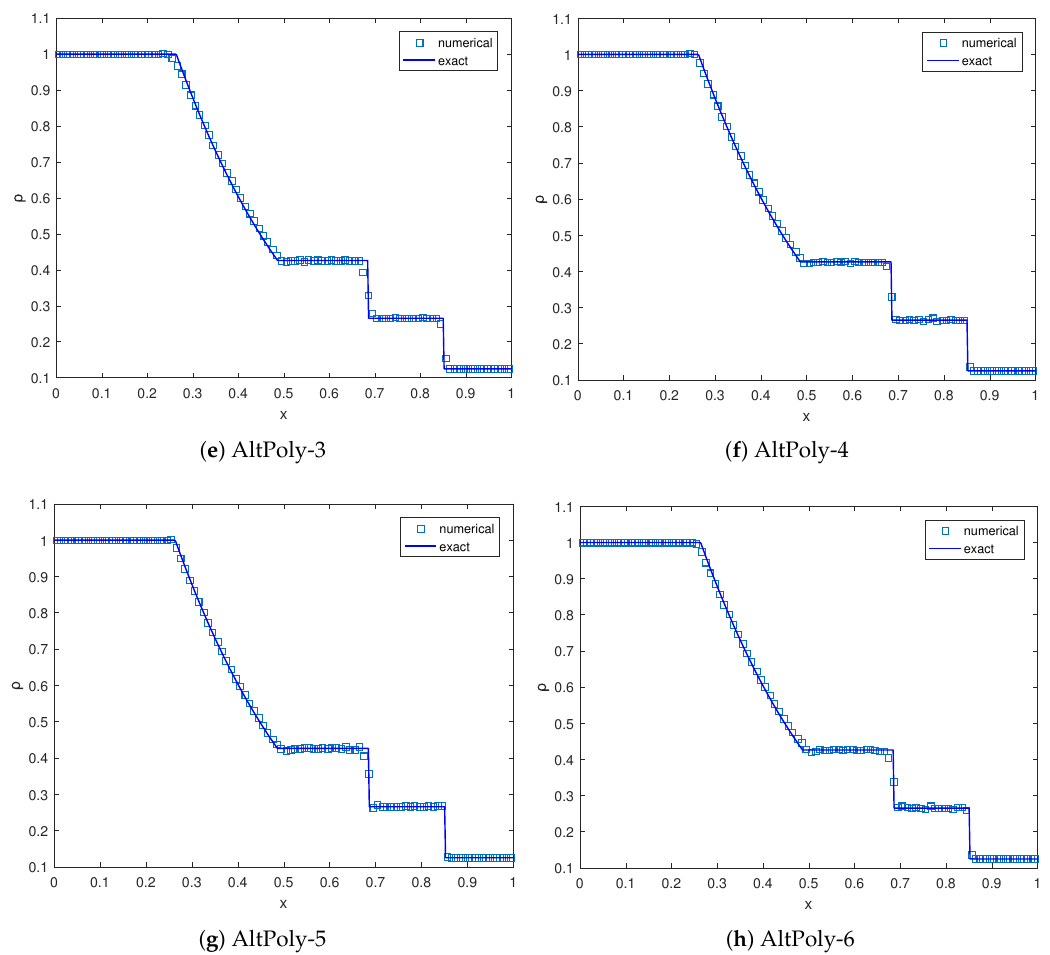
Figure 6. Numerical results of Sod’s problem at t = 0.13 with N = 100 cells. ∆ t = 0.2 ∆ x , 0.15 ∆ x , 0.1 ∆ x , and 0.05 ∆ x , respectively.